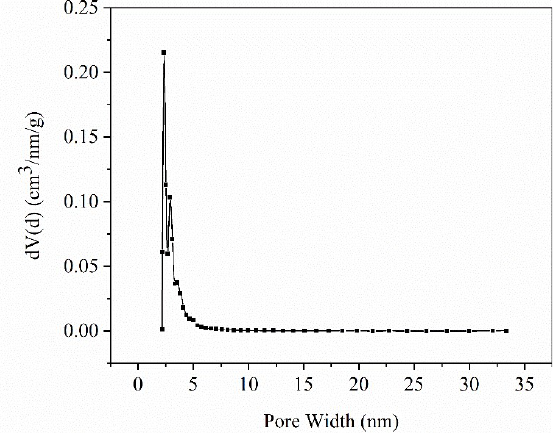
Figure 2. Pore size distribution curve of ASB. dV(d): Pore size per nanometer spacing, pore volume per gram of biochar.